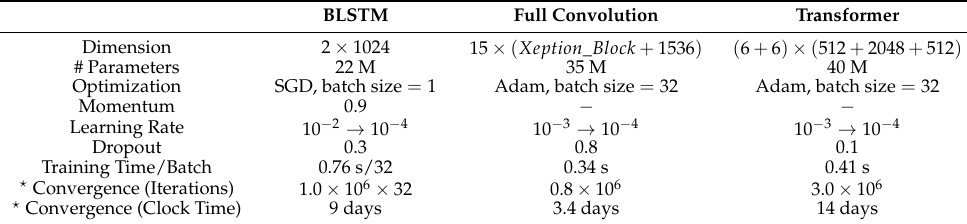
Table 3. Structural and training details of the temporal backbones used in